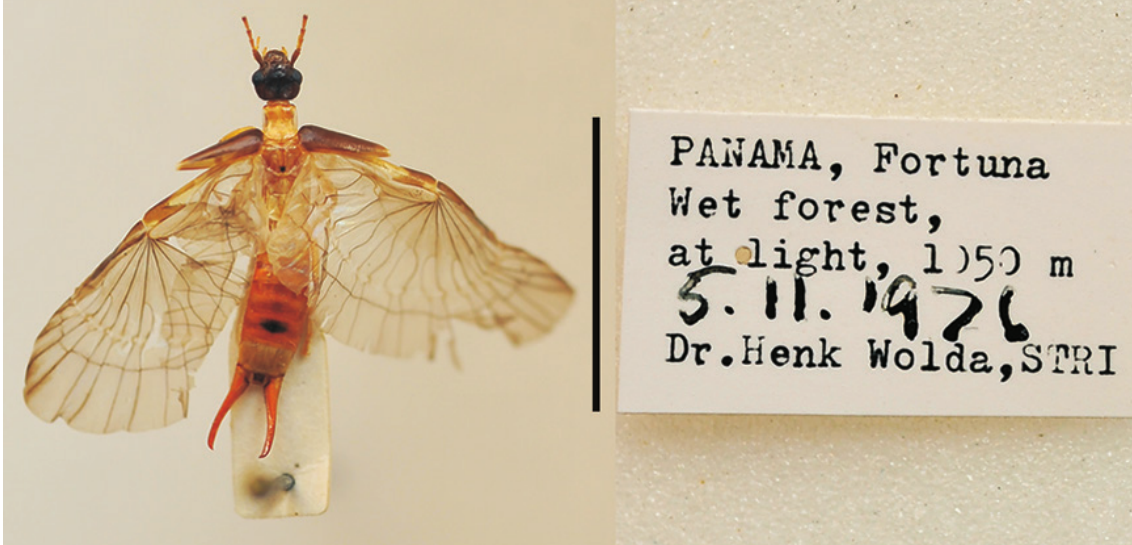
Fig. 11. The only specimen at MMUE mounted with wings unfurled, Purex remotus (Burr, 1899) from Panama, the Manchester Museum. Scale bar = 1